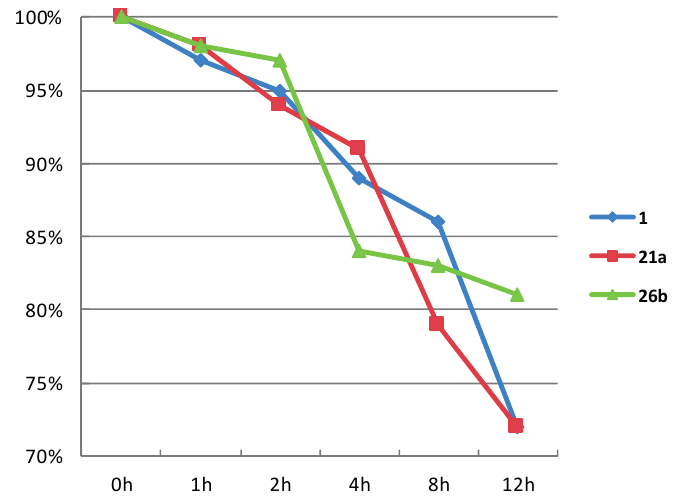
Figure 2. Chemical stability investigation of compounds 1 , 21a and 26b